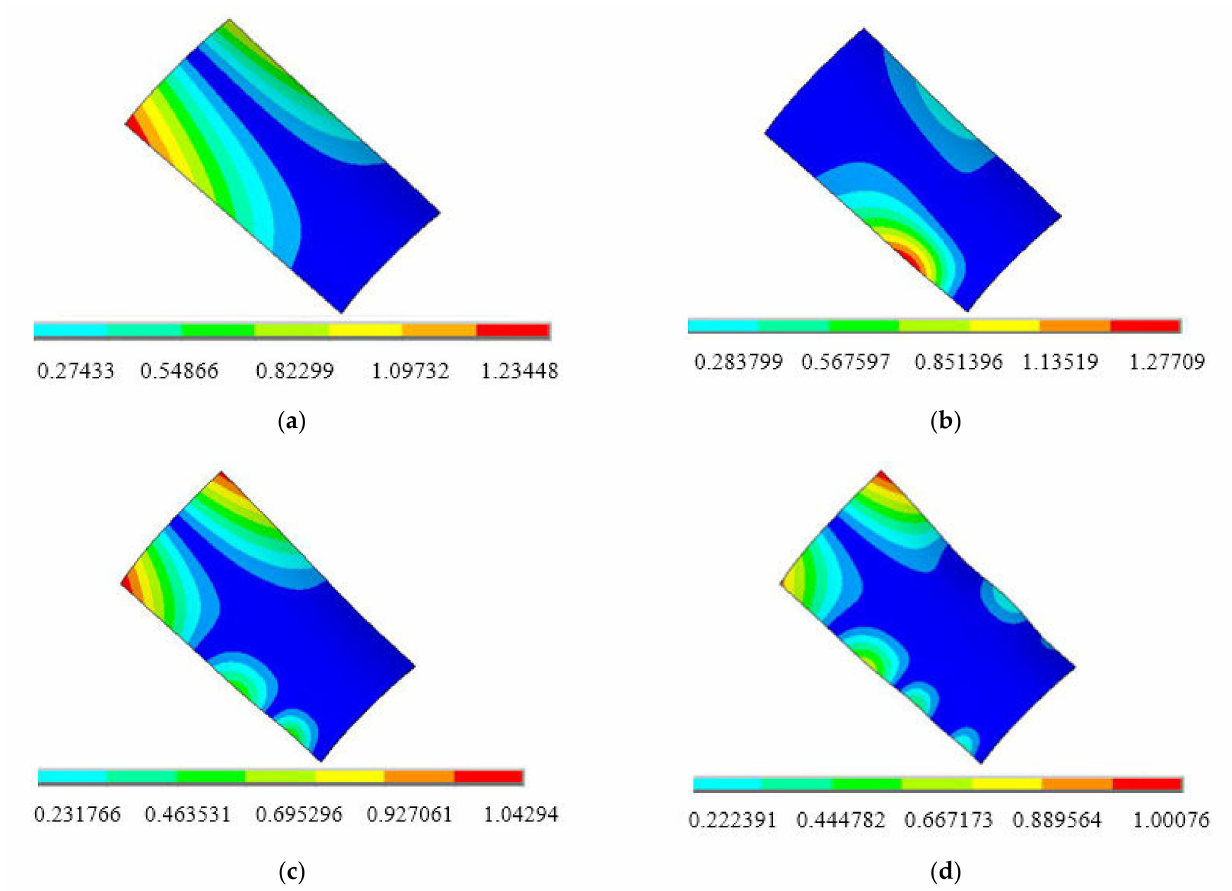
Figure 11. The nonlinear buckling modes of the blades [1]. ( a ) The first-order; ( b ) the second-order; ( c ) the third-order mode; and ( d ) the fourth-order